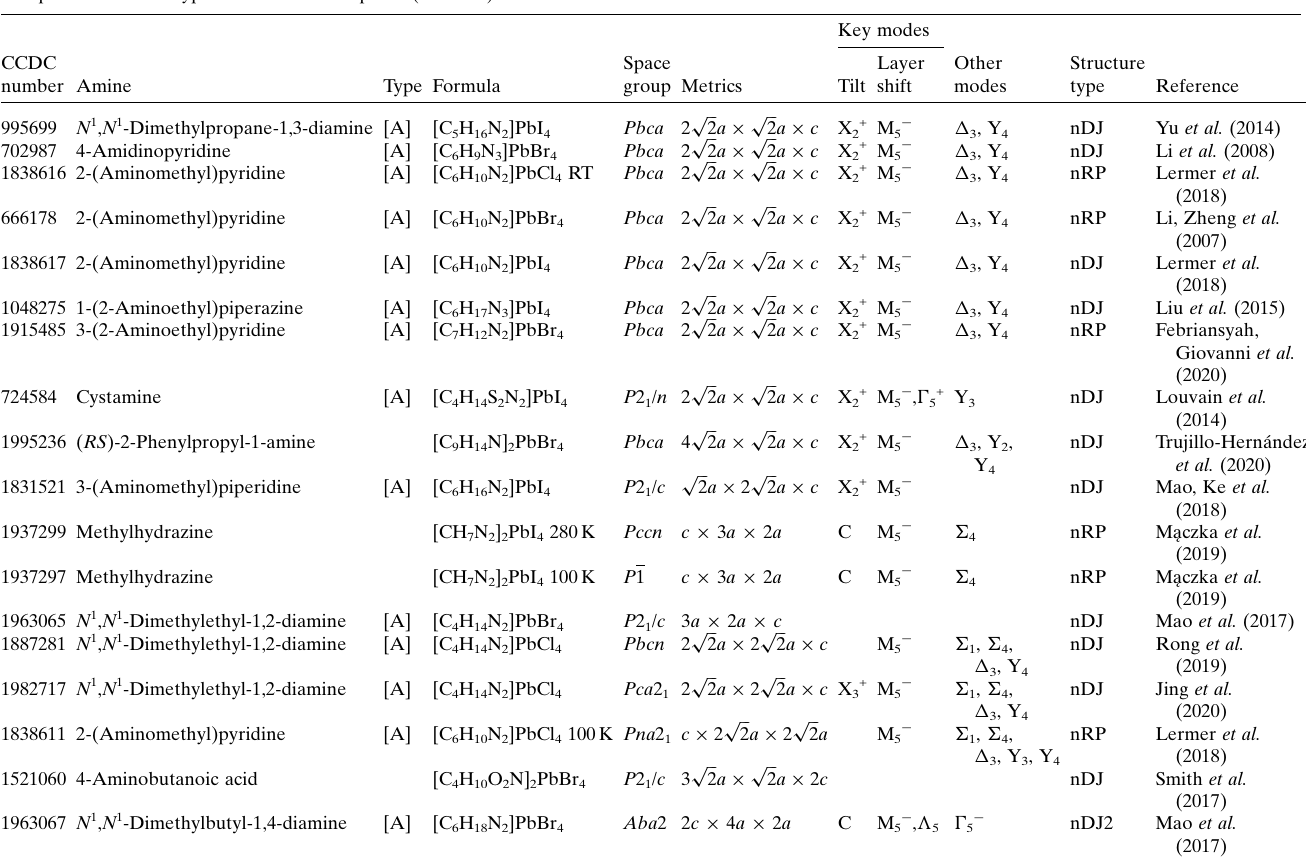
Table 5 Summary of experimentally known structures with at least one unit-cell metric larger than 2 a RP or 2 c RP . The parent structure type is that of the RP phase ( I 4/ mmm ).